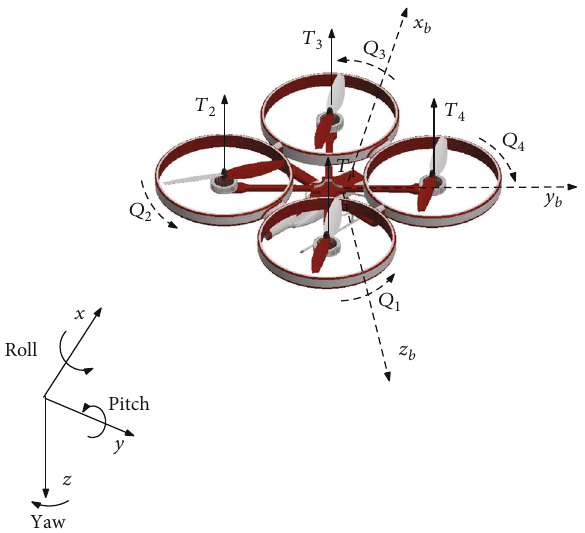
Figure 1: Rigid quadrotor UAV con fi